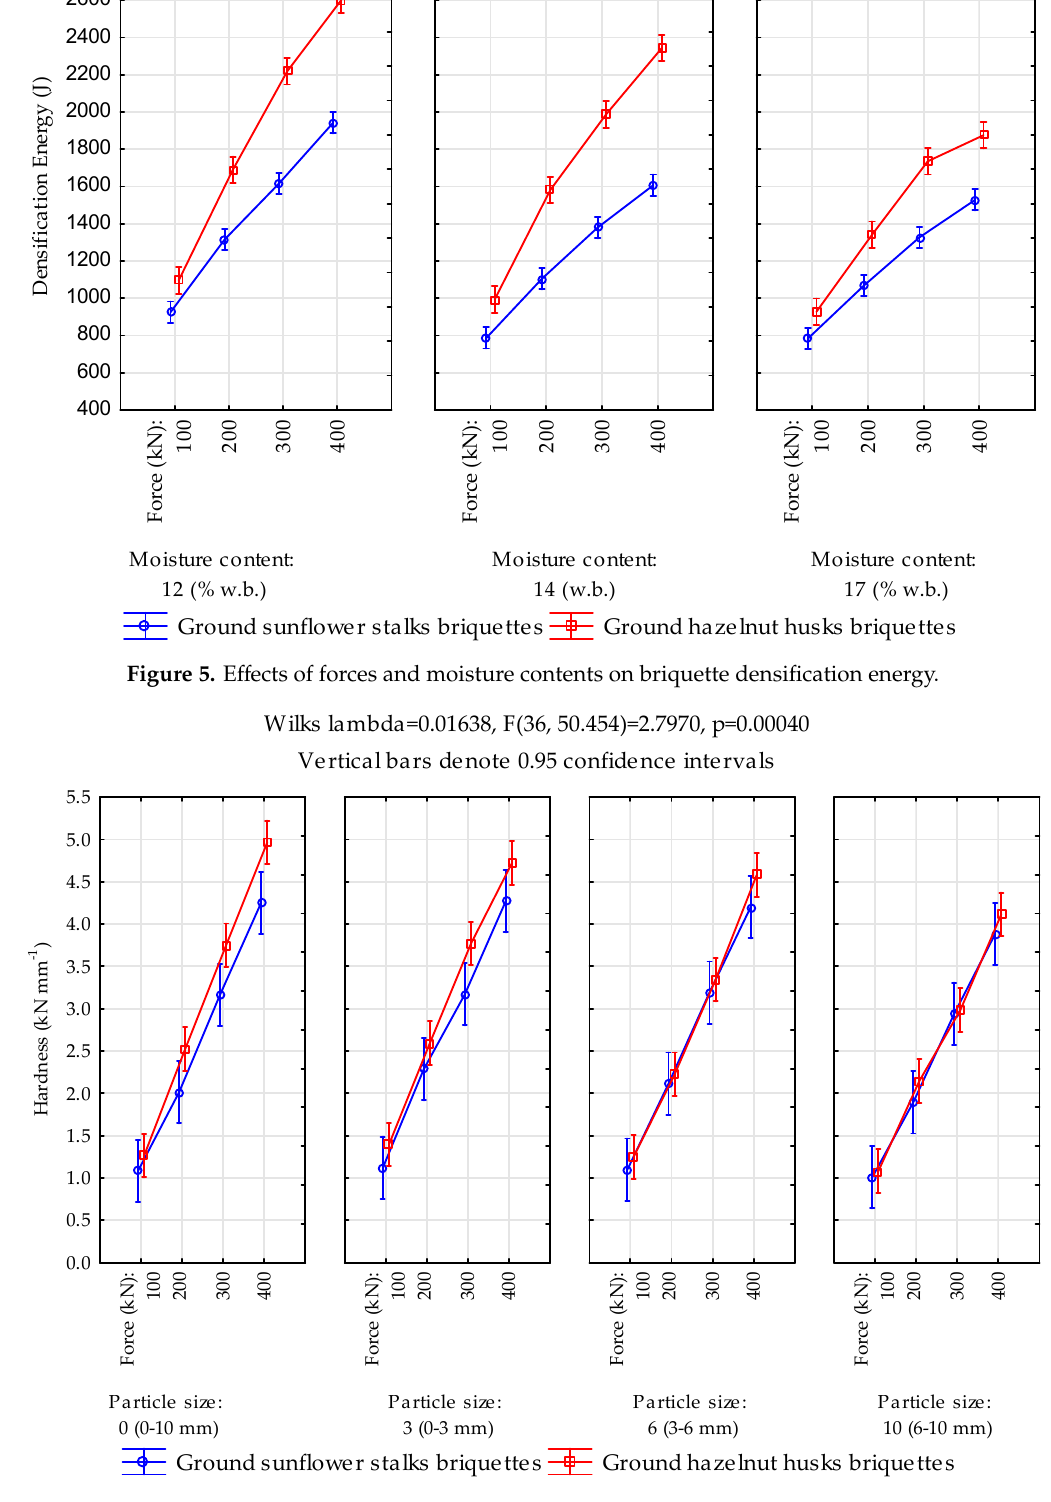
Ground sunflower stalks briquettes Ground hazelnut husks briquettes Figure 6. E ff ects of forces and particle sizes on briquette Figure 6. Effects of forces and particle sizes on briquette hardness. Wilks lambda=0.00841, F(24, 32.607)=3.9864, p=0.00015 Vertical bars denote 0.95 confidence intervals